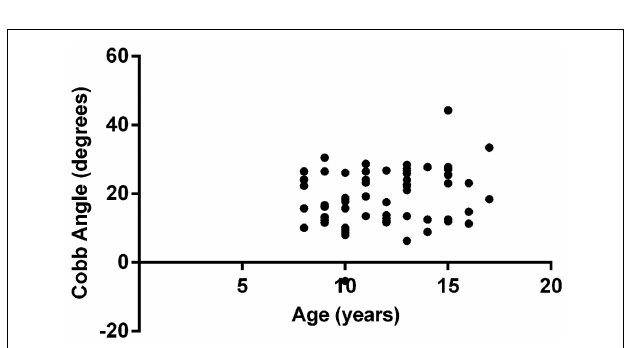
FIGURE 2 | Lack of correlation between Cobb angle and age .